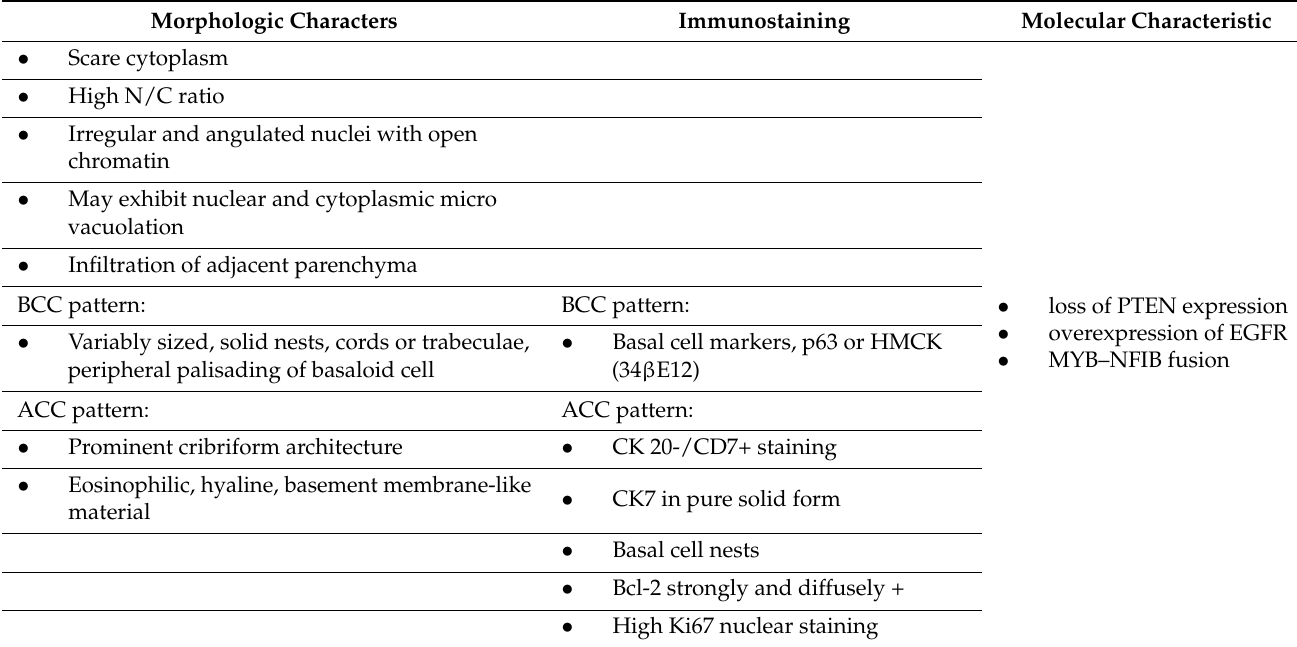
Table 1. Summary of the main pathological features of